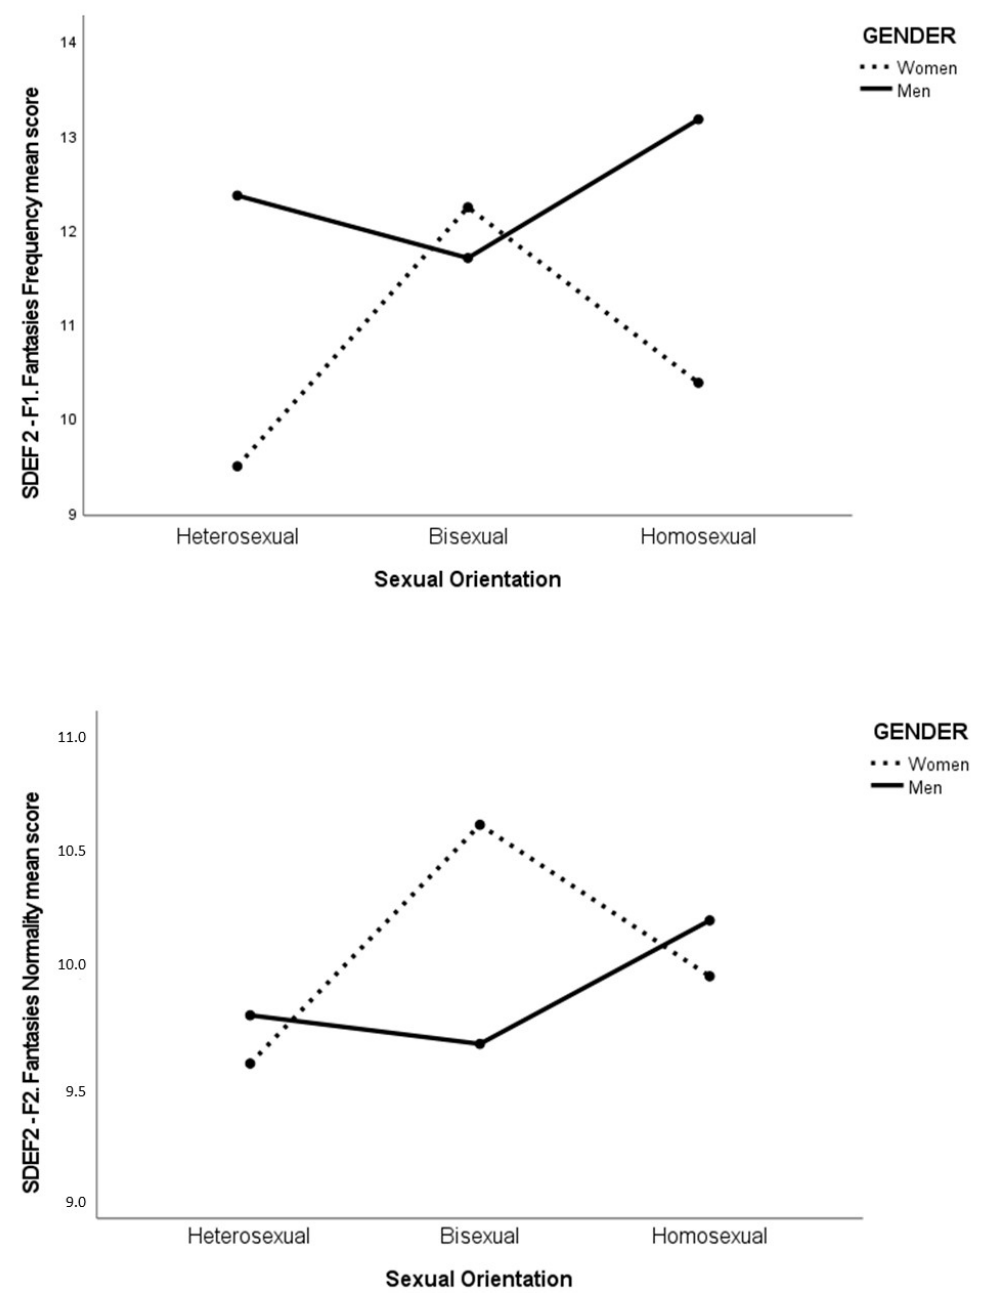
Figure 2. Diagrams of gender x sexual orientation for SDEF1 factors (MANCOVAs) (n = 1729). Table 6. MANCOVAs having FSFI and IIEF Clinical scores as independent variables and SDEF2 factors as dependent ones (n =